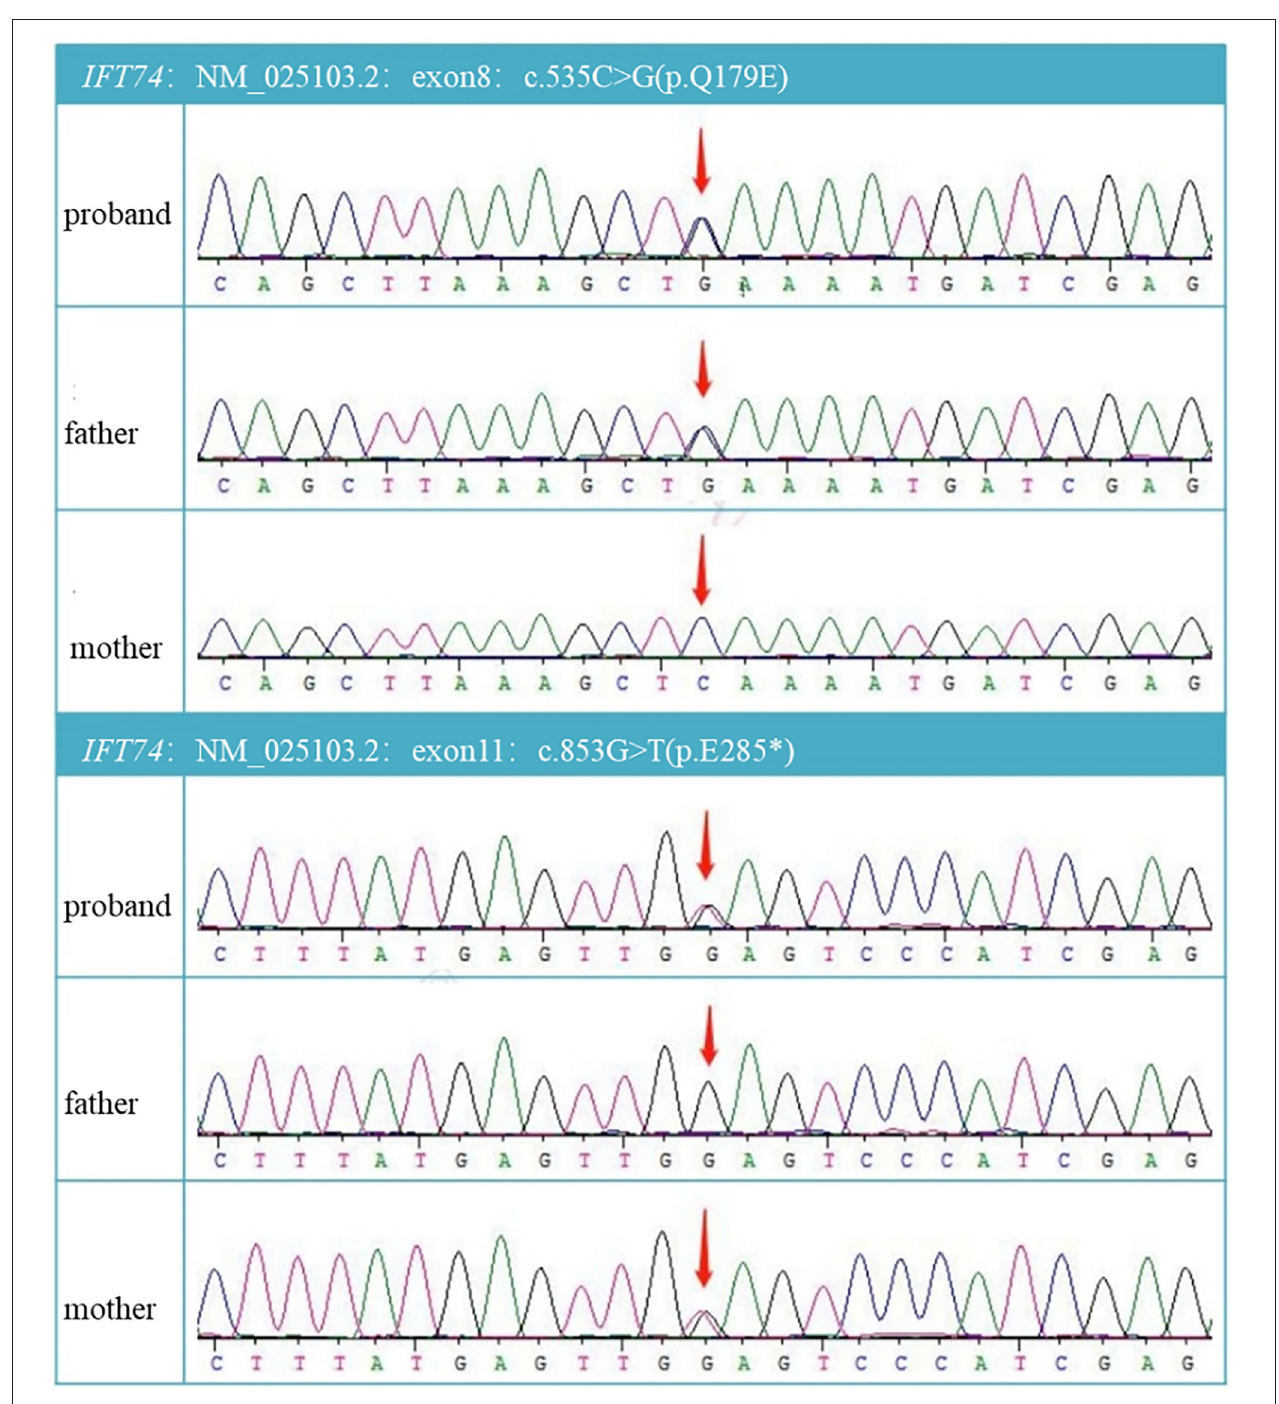
FIGURE 2 | DNA electrophoregram with the c.535C > G in exon8 and c.853G > T in exon11.